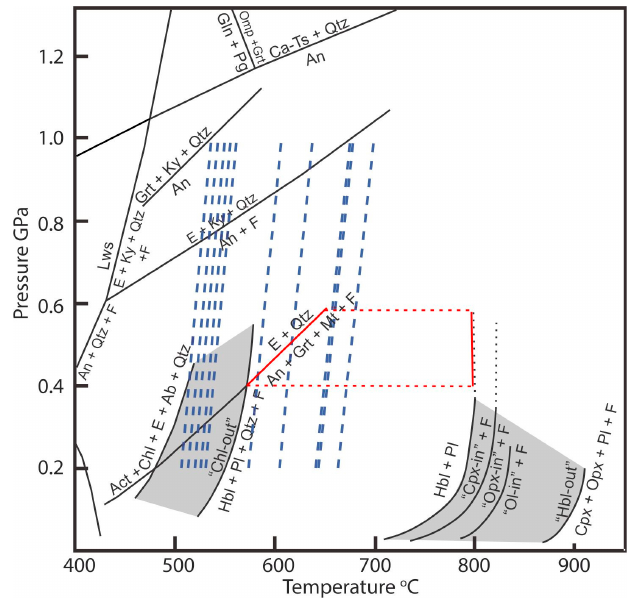
Figure 2. Simplified petrogenetic grid for metamorphosed mafic rocks modified after [28]. The red polygon represents the paragenesis hornblende, garnet, andesine, and magnetite (devoid of chlorite and clinopyroxene) described by [20] in amphibolites and amphibole schists of the Cedrolina Formation indicative of T > 570 °C and Pressures of 0.4–0.6 GPa. Dashed blue lines represent temperatures calculated using the Zr-in-rutile geothermometer for crystals in samples 14, 100, 105, and 106 (for details about the temperature calculations and dataset please refer to the text). Notice that the pressure effect for the 0.2–1.0 GPa range is less than 35 °C. Mineral abbreviations (Ab = Albite, Act = Actinolite, An = anorthite, Ca-Ts = Ca-tschermakite, Chl = chlorite, Cpx = Ca-clinopyroxene, E = an epidote mineral: epidote, zoisite, or clinozoisite, F = aqueous fluid, Gln = glaucophane, Grt = garnet, Hbl = hornblende, Ky = kyanite, Lws = lawsonite, Mt = magnetite, Ol = olivine, Omp = omphacite, Opx = orthopyroxene, Pg = paragonite, Pl = plagioclase, Qtz = quartz). It has been suggested that the granite-greenstone belt association of central Brazil could represent an Archean crustal segment and, as a consequence, the supracrustal rocks of northern Goiás State (greenstone belts of Crixás, Guarinos and Pilar de Goiás) were also considered to be Archean in age [29]. However, Paleoproterozoic ages have been proposed for the sedimentary sequences of the greenstone belts of central Brazil [30,31,25]. Sm–Nd whole rock analyses were carried out for a basal metachert and three calcsilicate rocks from different stratigraphic positions of the Boqueirão Formation of the Pilar de Goiás greenstone belt [31]. The analyzed samples yielded a Sm–Nd isochron date of 2189 ± 36 Ma suggesting a Paleoproterozoic age. According to the same